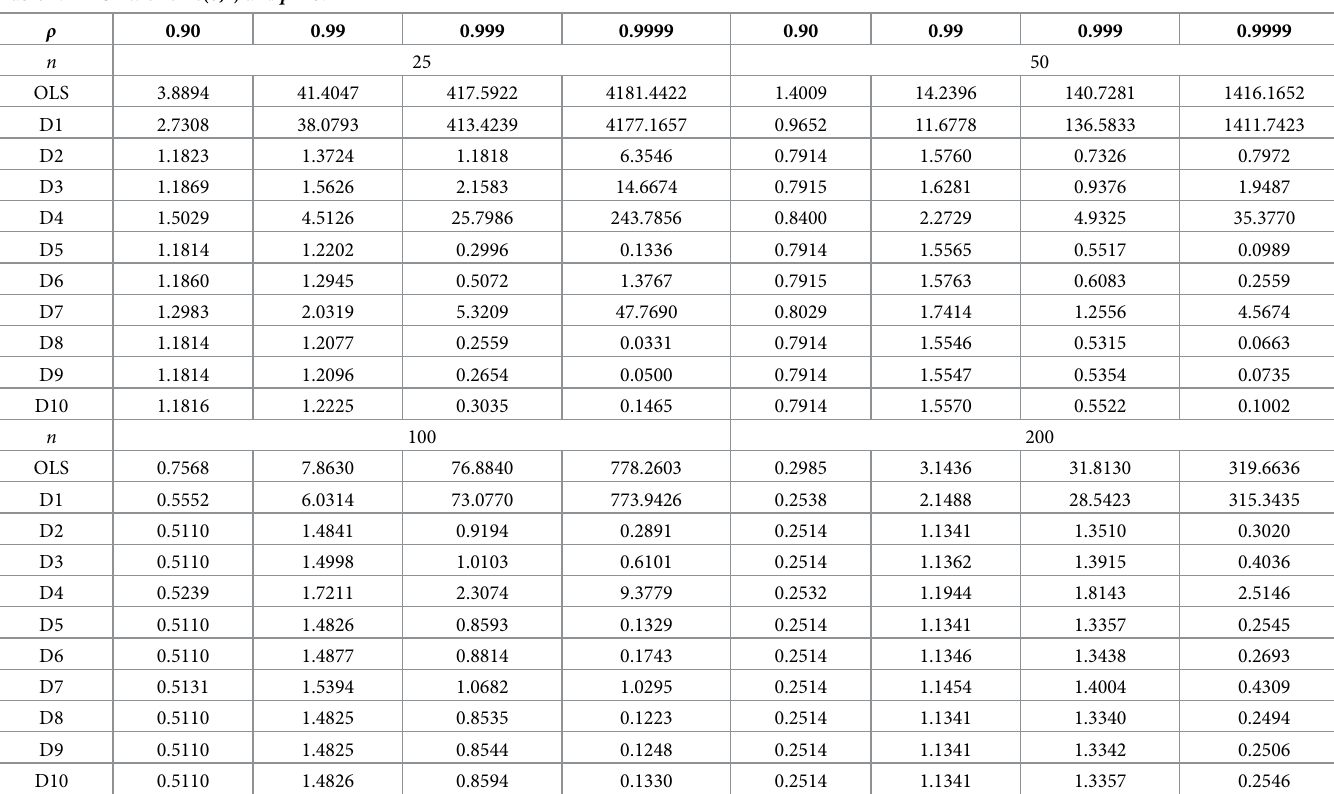
Table 2. EMSE with � ~ N (0,1) and p = 8